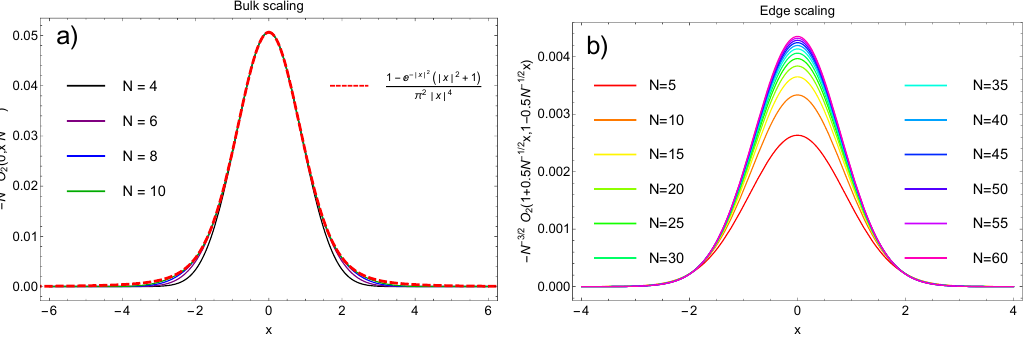
Figure 12 . The two-point eigenvector correlation function O the microscopic a) bulk regime, z 1 = 0, z 2 = x p The red dashed line is Chalker and Mehlig’s exact result (5.12). In the bulk microscopic regime O 2 scales as N 2 and at the edge as N 3 = 2 . The rapid convergence to the limiting bulk scaling suggest that the corrections are exponentially small, while the hypothetical edge scaling seems to have 1 =N